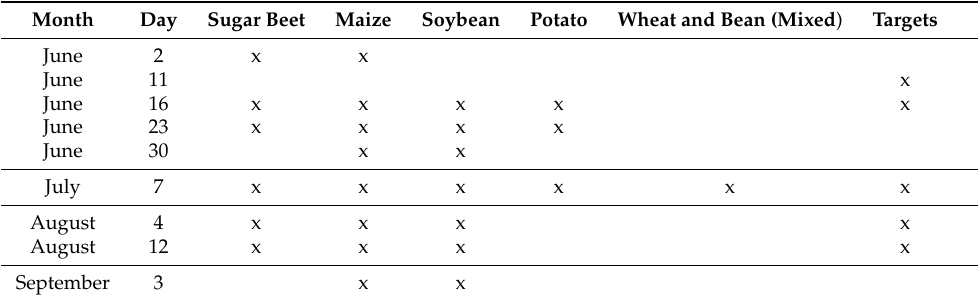
Table 1. Datasets captured at the field experiment shown in Figure 3 during the growing season of 2021. The markers “x” highlight observed plots at the corresponding